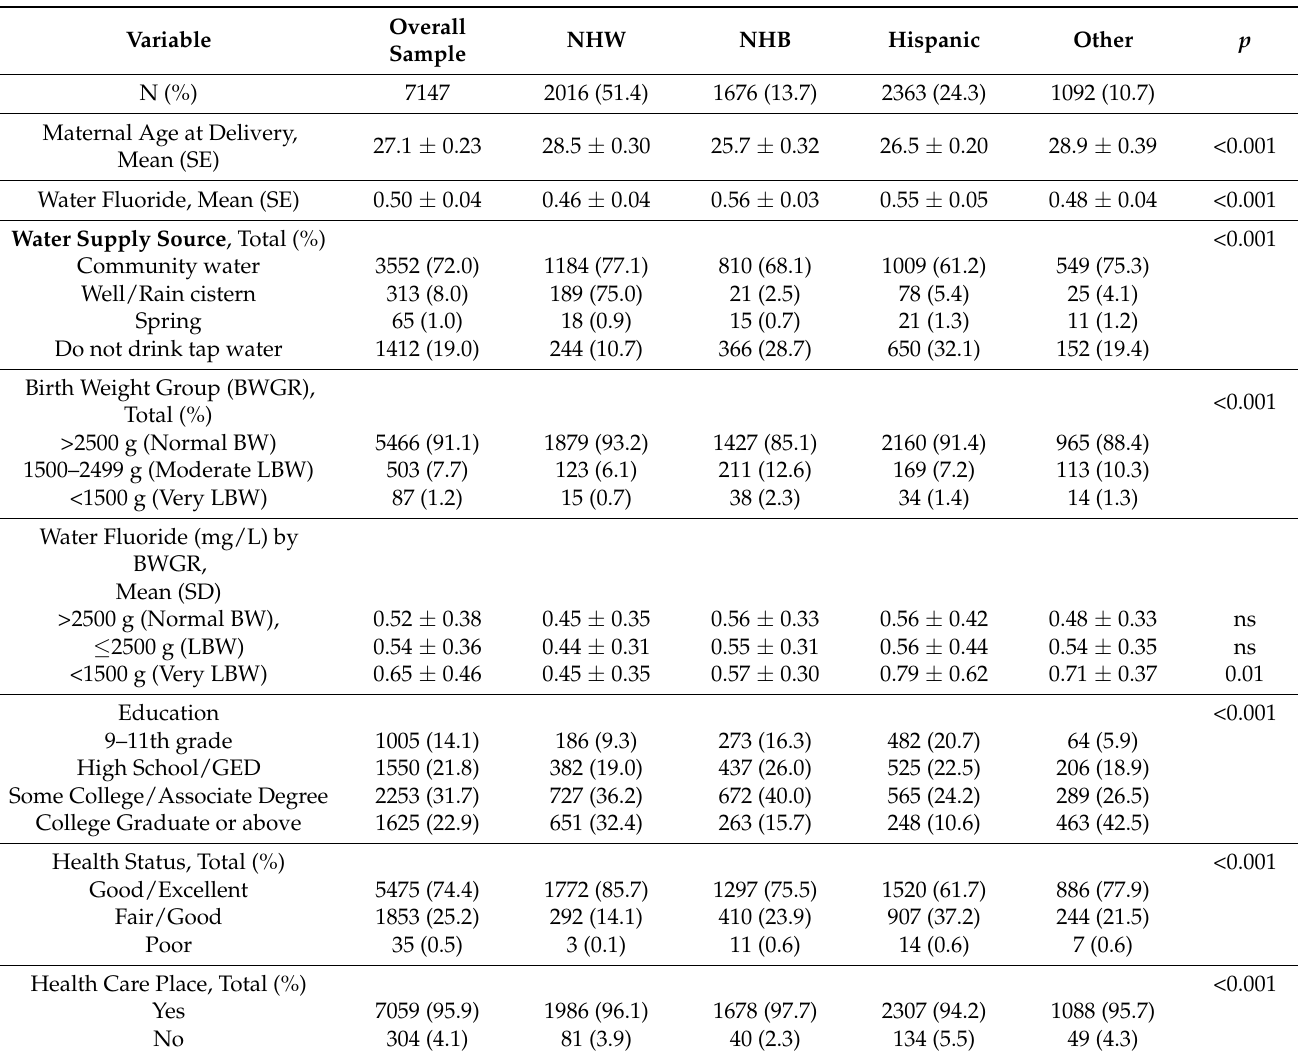
Table 1. Characteristics of study participants by racial/ethnic group: NHANES